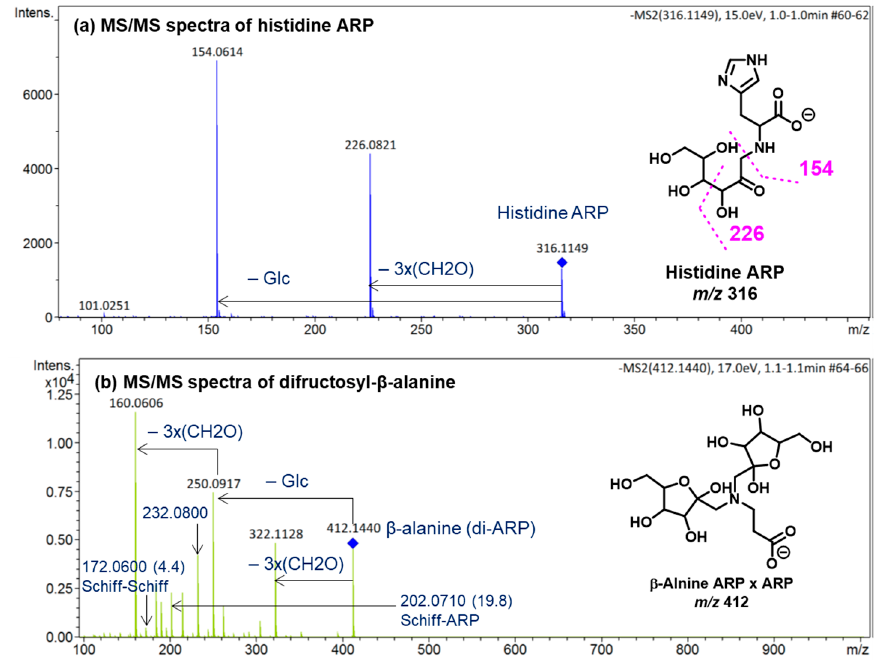
Figure 4. ESI ( − ve)/MSMS spectra of molecular ions of the synthetic ( a ) histidine ARP and ( b ) N , N - difructosyl- β -alanine (ARP-ARP). All identified ions are deprotonated [M − H] − . The specific tautomeric forms shown in the figure are for clarity only.